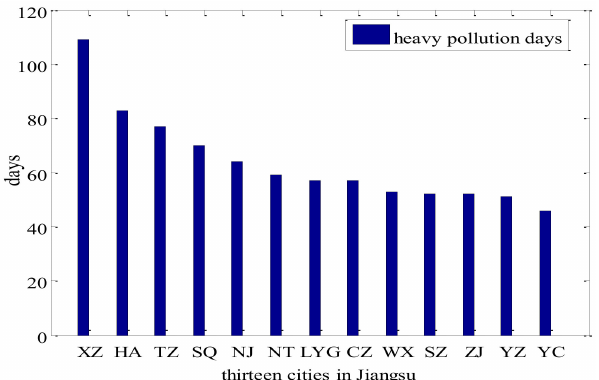
Figure 3. Heavy pollution days of 13 cities in Jiangsu Province, China (unit: days). (Lianyungang: in short LYG; Xuzhou: XZ; Nanjing: NJ; Nantong: NT; Suqian: SQ; Zhenjiang: ZJ; Taizhou: TZ; Huaian: HA; Yancheng: YC; Changzhou: CZ; Suzhou: SZ; Yangzhou: YZ; Baoshan: BS; Sheyang: